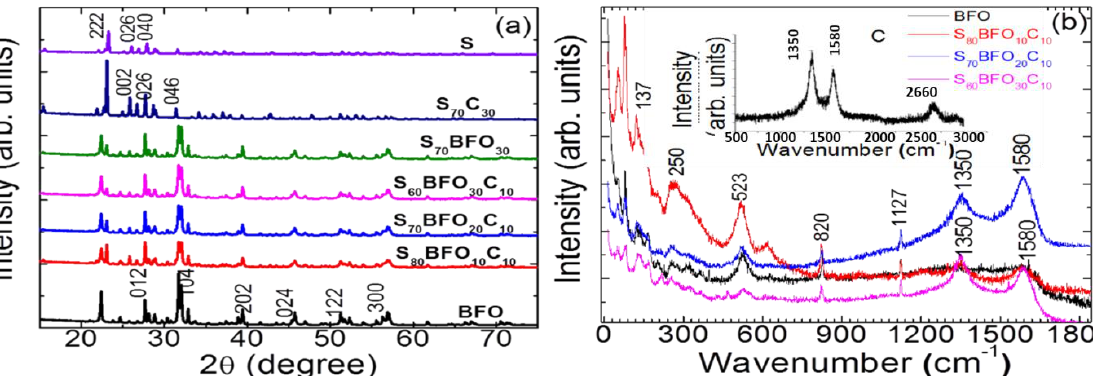
Figure 2. ( a ) X-ray diffraction spectra for different BFO – C-S composite cathode materials together with pristine sulfur (on top) and BFO (on bottom) materials as a reference, and ( b ) Room temperature Raman spectra for different BFO – C-Sulfur composite cathode materials together with pristine BFO Raman spectra (black color) and pristine carbon spectra (in inset).